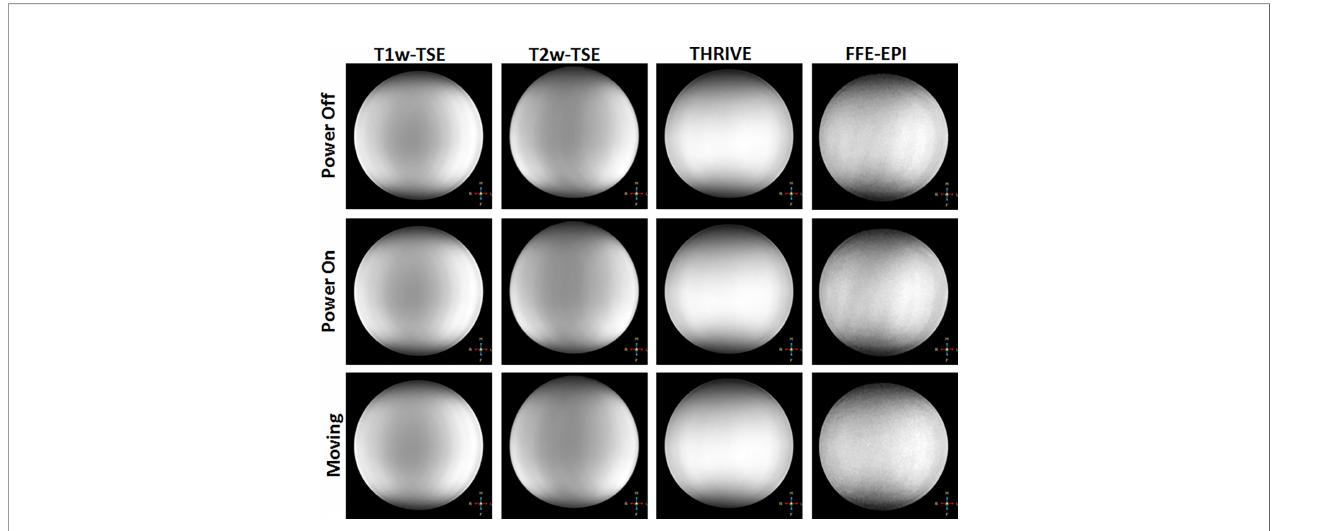
FIGURE 6 | Representative images showing qualitative changes in MR images of a saline phantom for different sequences (in columns) and with the robot powered off (top row), powered on (middle row) and robot moving (bottom